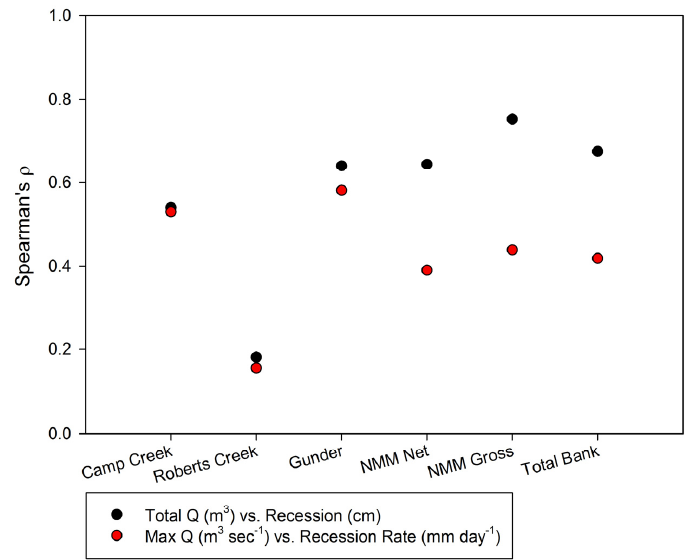
Figure 13. Correlation between total pin measurement period discharge (Total Q) and measurement period mean pin recession rate (Recession), and correlation between maximum pin measurement period discharge (Max Q) and pin measurement period mean recession rate (Recession Rate) for streambank materials, Walnut Creek Iowa. Spearman’s rank correlation coefficient denoted as Spearman’s ρ .